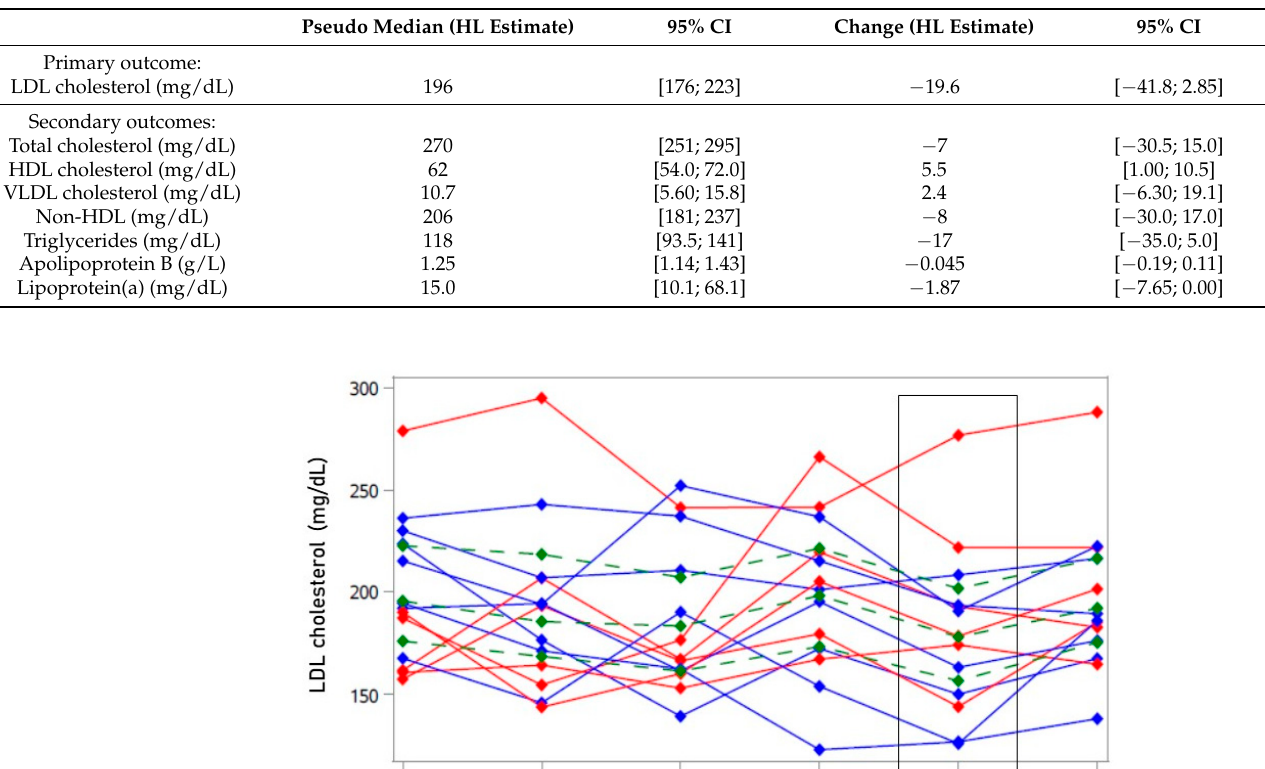
Table 2. Baseline lipid profile and changes in lipid profile after 12 weeks of treatment with bulevirtide (5 mg/d; n = 13, per-protocol population). HL: Hodges–Lehmann, CI: Confidence interval.